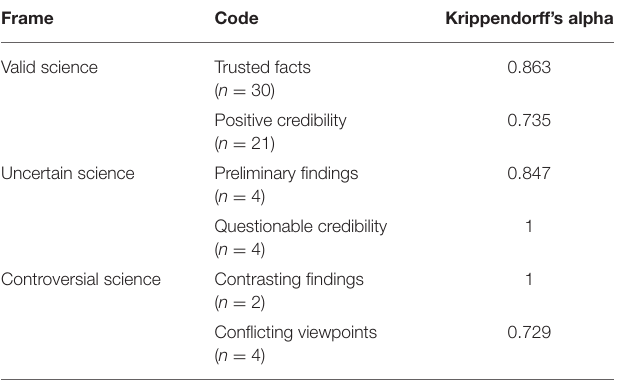
TABLE 2 | Inter-coder